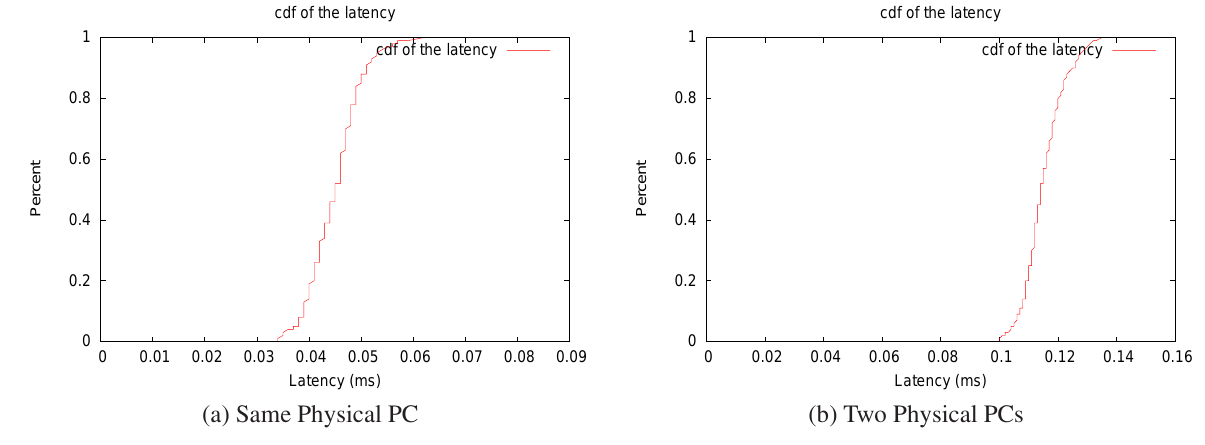
Figure 5. cdf of latency of links within an